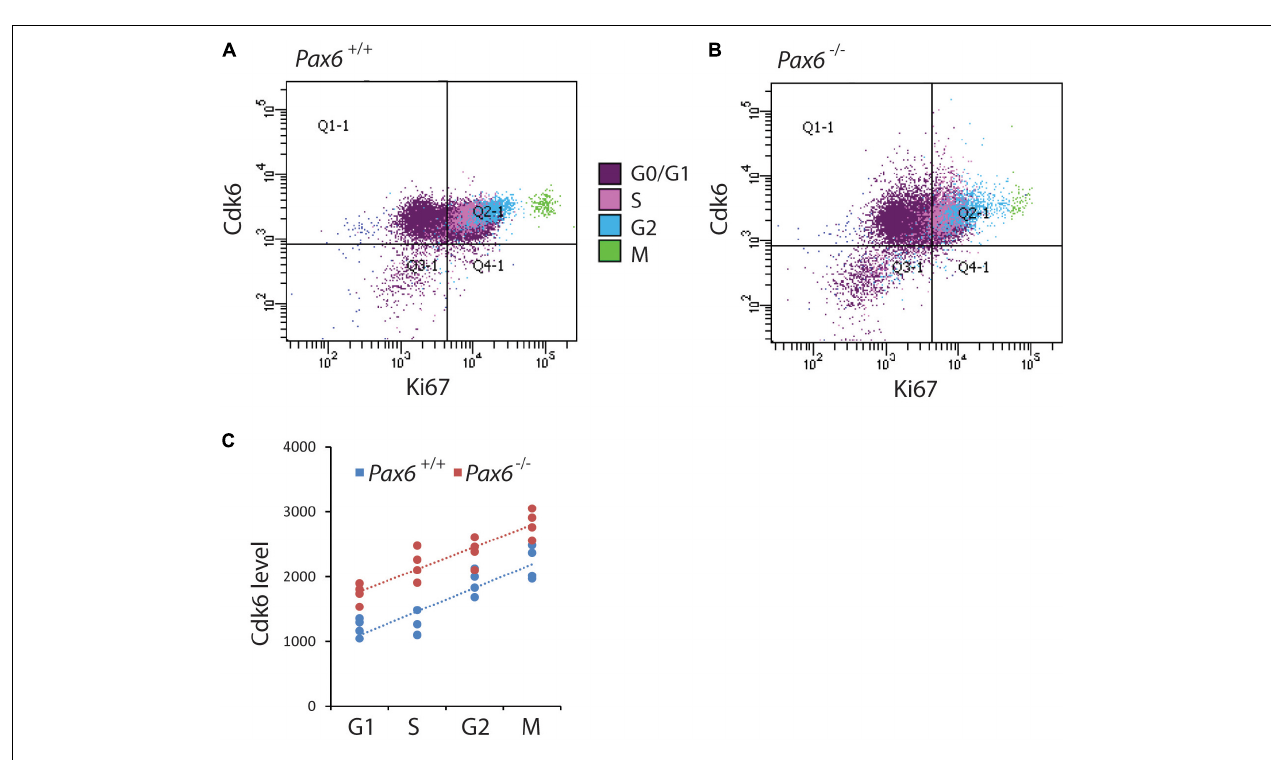
FIGURE 4 | Flow cytometric analysis of Cdk6 levels at different phases of the cell cycle in Pax6 + / + and Pax6 − / − cortex at E12.5. (A,B) Fluorescence intensity of Cdk6 against Ki67: Samples from a Pax6 + / + and a Pax6 − / − embryo with cells classified according to their cell cycle phase by methods illustrated in Figure 3 . G1 cells were distinguished from G0 cells by positivity for Ki67 in quadrants Q2-1 and Q4-1 (cells in quadrants 1-1 and 3-1 were negative for Ki67). (C) Relative levels of Cdk6 in the cortex of four Pax6 + / + and four Pax6 − / − embryos at each phase of the cell cycle. Each data point is the average level in the cortex of one embryo. Regression analysis of levels of Cdk6 against cells cycle phase gave r 2 values of 0.78 for Pax6 + / + data and 0.81 for Pax6 − / − data. ANOVA showed a significant effect of genotype ( α = 0.05) and Sidak’s multiple comparisons tests showed significantly higher levels of Cdk6 in Pax6 - / − cortex in all phases (G1, p = 0.0075; S, p < 0.0001; G2, p = 0.0167; M, p = 0.0019).